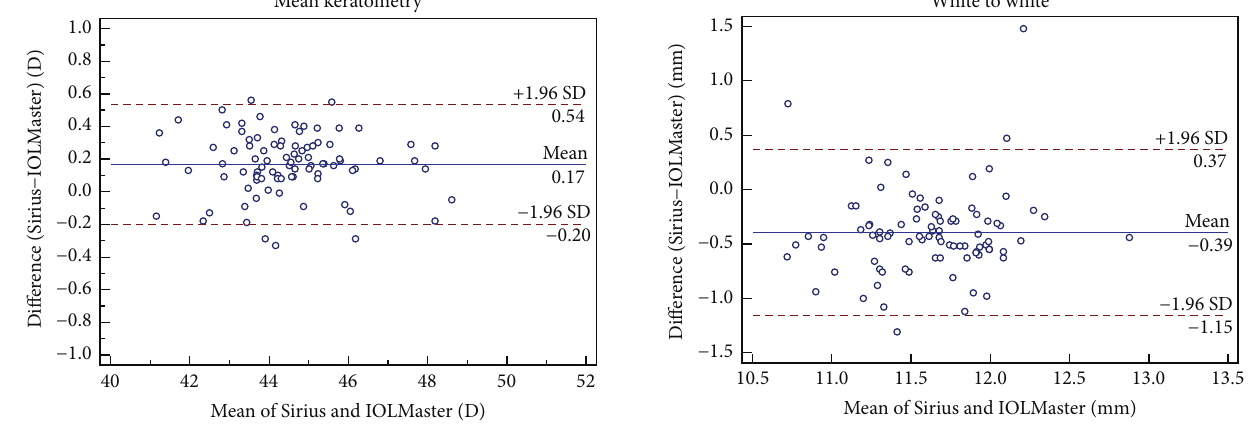
Figure 4: Bland-Altman plots of agreement of mean Keratometry readings taken with the Sirius Scheimpflug/Placido photography- based topography system and IOLMaster partial coherence inter- ferometry. The solid line indicates the mean difference (bias). The upper and lower lines represent the 95% limits of agreement.